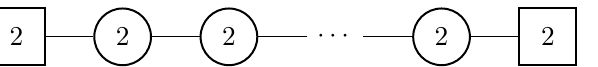
Figure 3 . The quiver diagram of the class S theory T C for C being sphere with ( n + 2) regular punctures. There are ( n − 1) circles, each of which stands for an SU(2) gauge group. case of C being a sphere with ( n + 2) regular punctures. The corresponding T quiver SU(2) gauge theory as shown in figure 3. The AGT correspondence